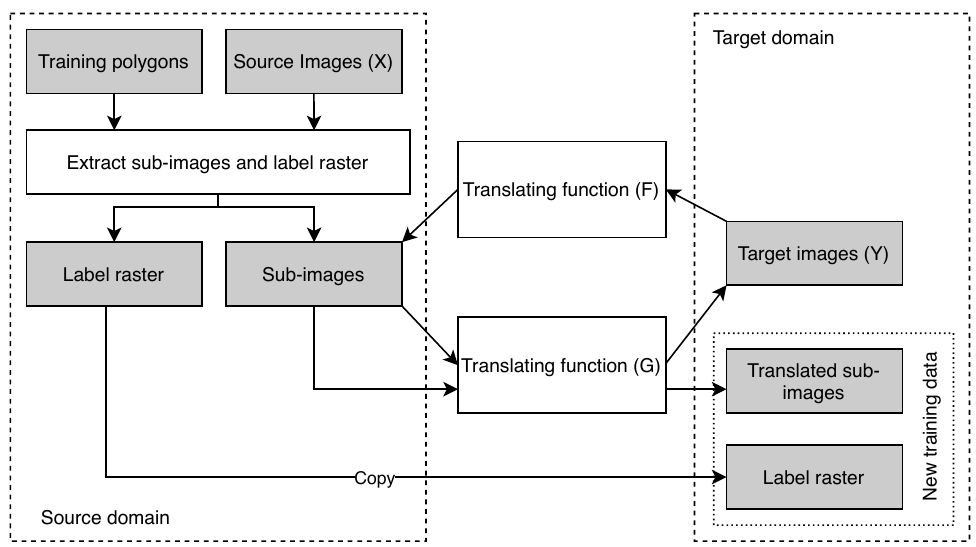
Figure 4. Flowchart showing the CycleGAN workflow used to generate new training data.